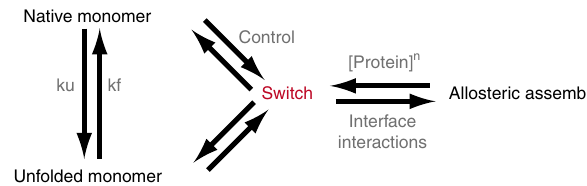
Fig. 1 Fold-switch mechanism for allosteric assembly. The general thermodynamic scheme to introduce allosteric control of assembly is based on thermodynamically coupling a metamorphic transition in the monomer to the assembly